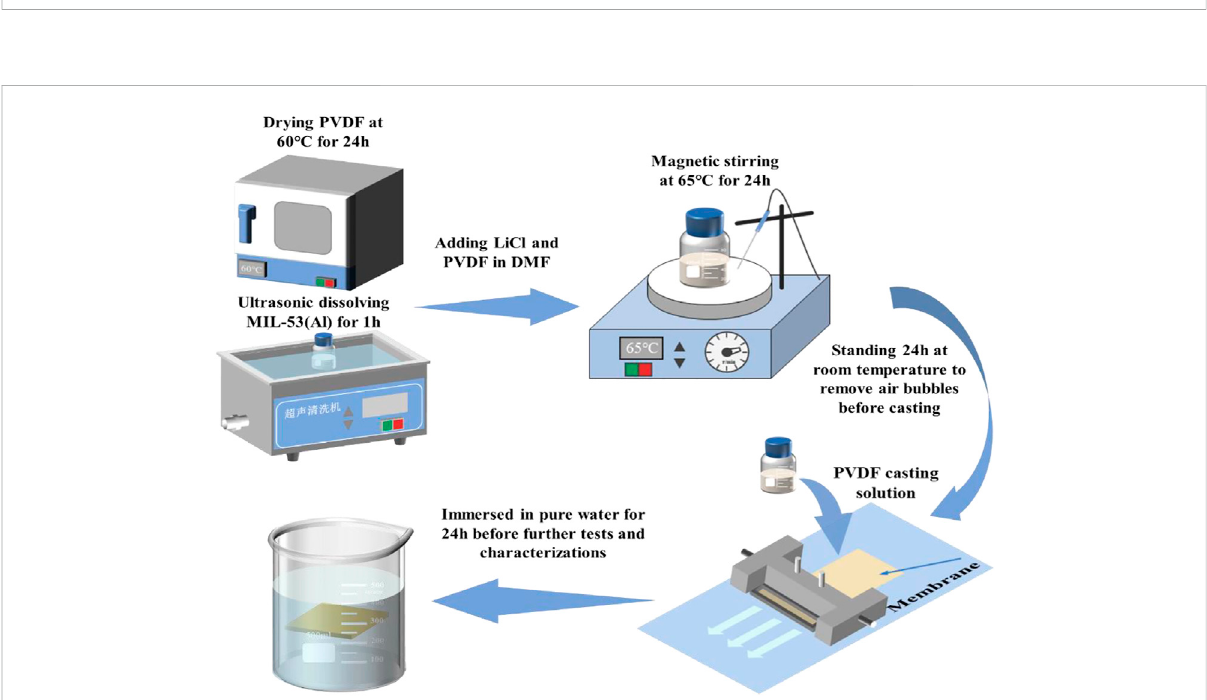
FIGURE 2 Schematic illustration of the preparation process of MIL/LiCl@PVDF